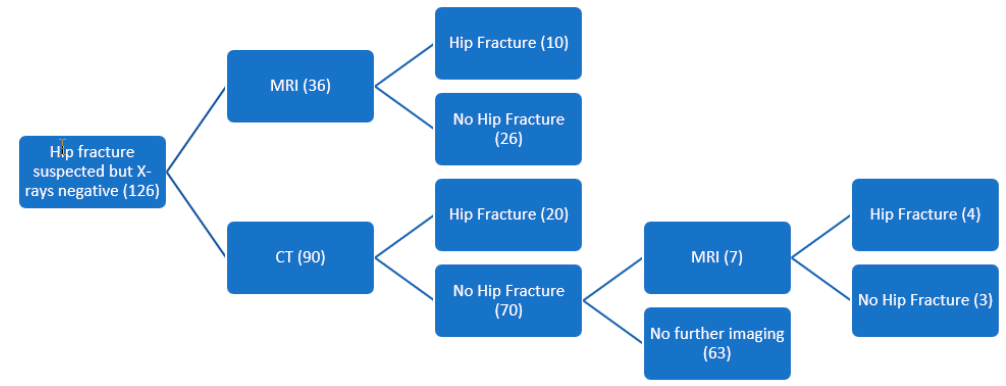
Figure 1. Cross-sectional imaging performed and its outcomes.